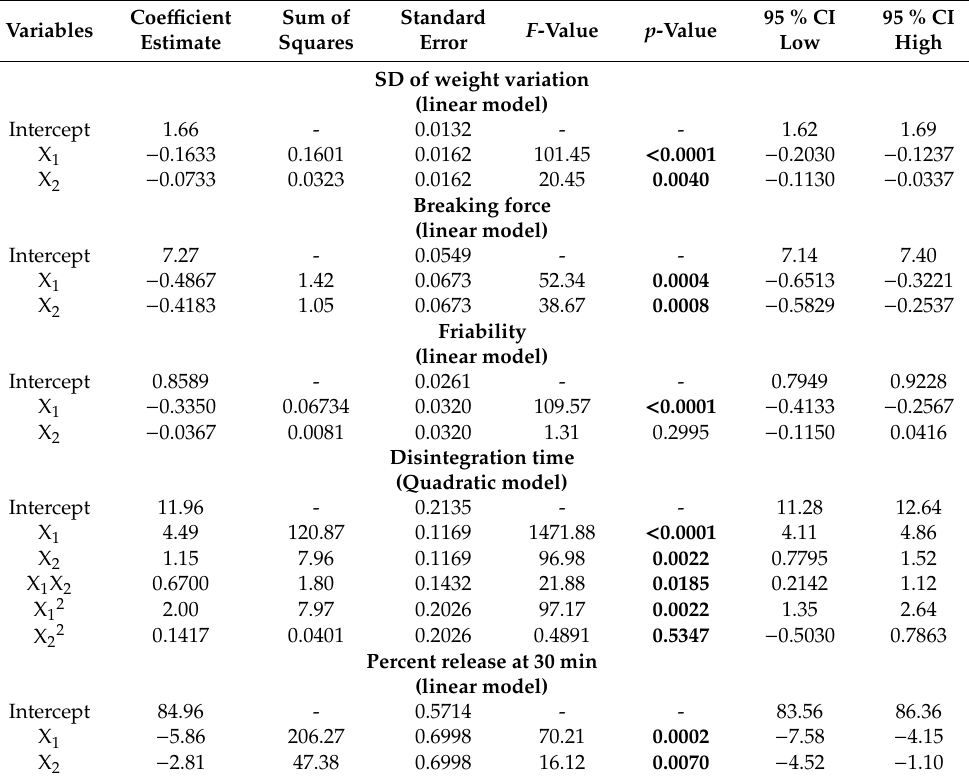
Table 5. Regression analysis of dependent responses of CNG